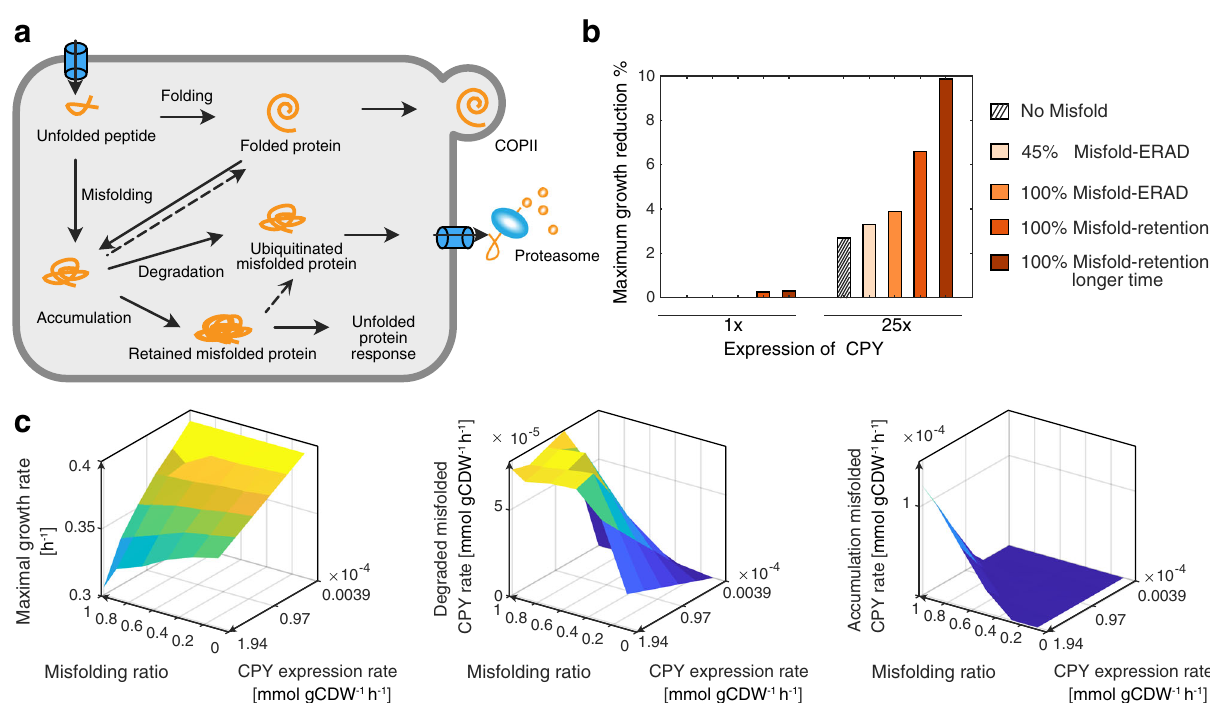
Fig. 3 Simulation of CPY overexpression. a Schematic view of different routes for expressed CPY. Processes represented in dotted lines are not considered in the pcSecYeast. b Reduction of simulated maximum speci fi c growth rate due to expression at speci fi c levels of CPY following different routes. 1x means its native expression level, 25x means 25-fold of its native expression level. Native expression level of CPY is from PaxDb database 22 . c Simulations for various CPY expression levels and misfolding ratios with the constraint for retro-translocation enzymes. Source data are provided as a Source Data fi